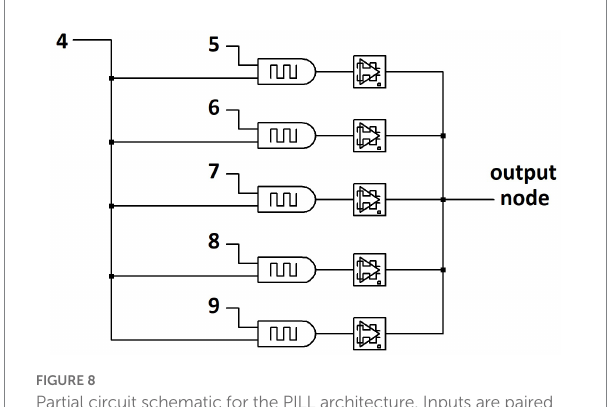
FIGURE 8 Partial circuit schematic for the PILL architecture. Inputs are paired